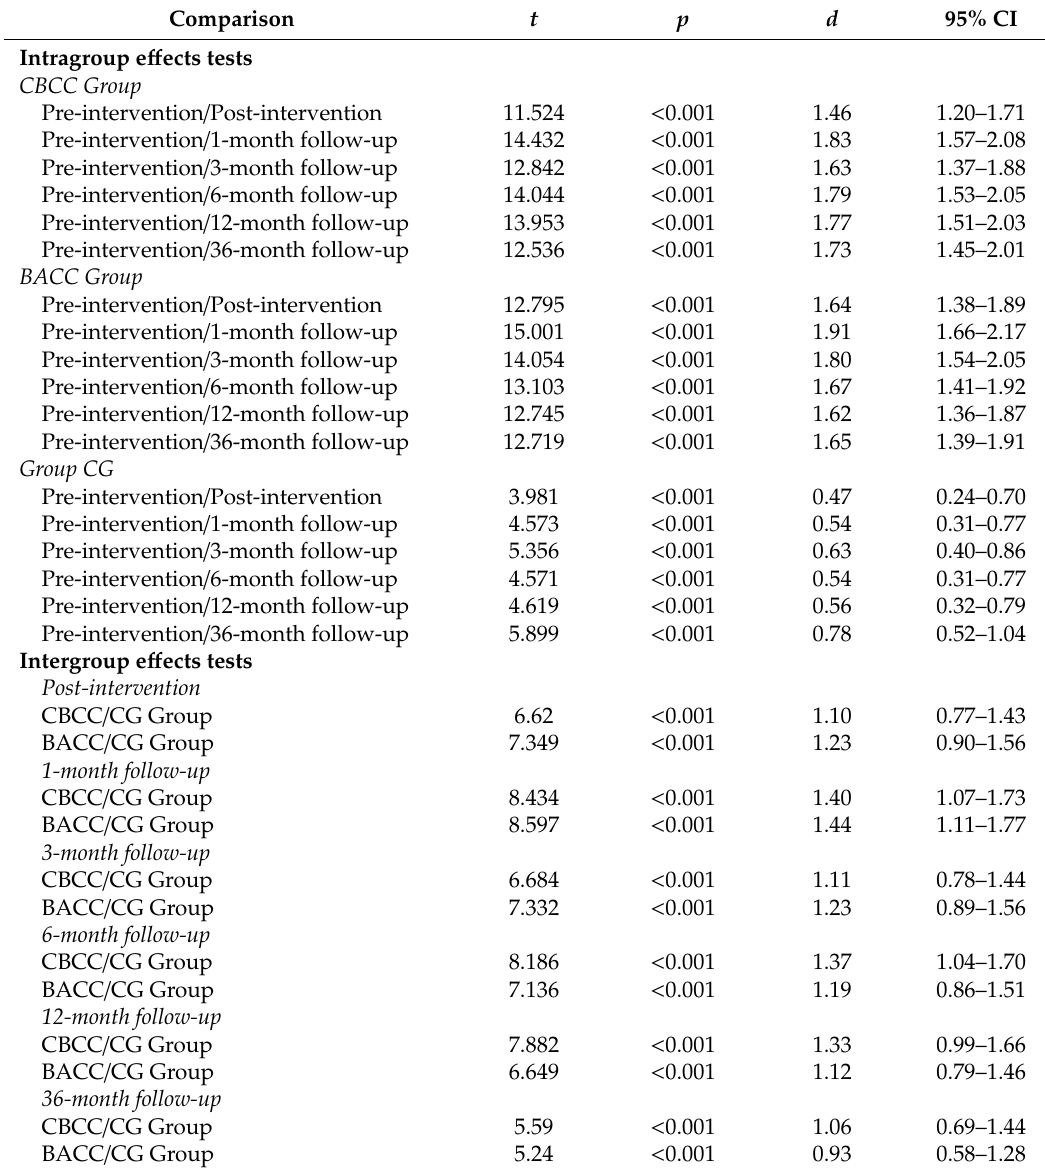
Table 4. Student’s t statistics and standardized mean di ff erences for intragroup and intergroup e ff